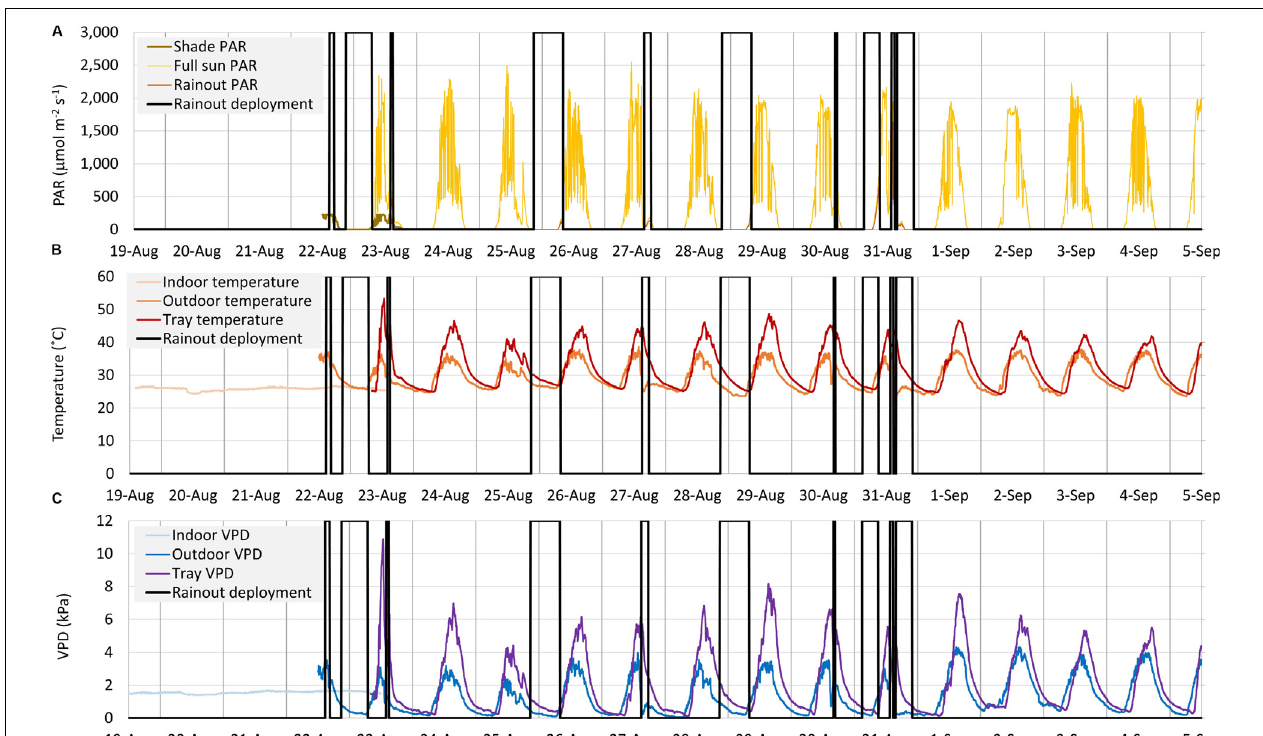
FIGURE 1 | Time course for Photosynthetically Active Radiation (PAR) (A) , Temperature (B) and Vapor Pressure Deficit (VPD) (C) under indoor, shade (acclimation), full-sun and during rainout shelter deployment phases of the outdoor Water Use Efficiency (WUE) assay. Tray temperature and VPD reflect the average of three sensors adjacent to the plant